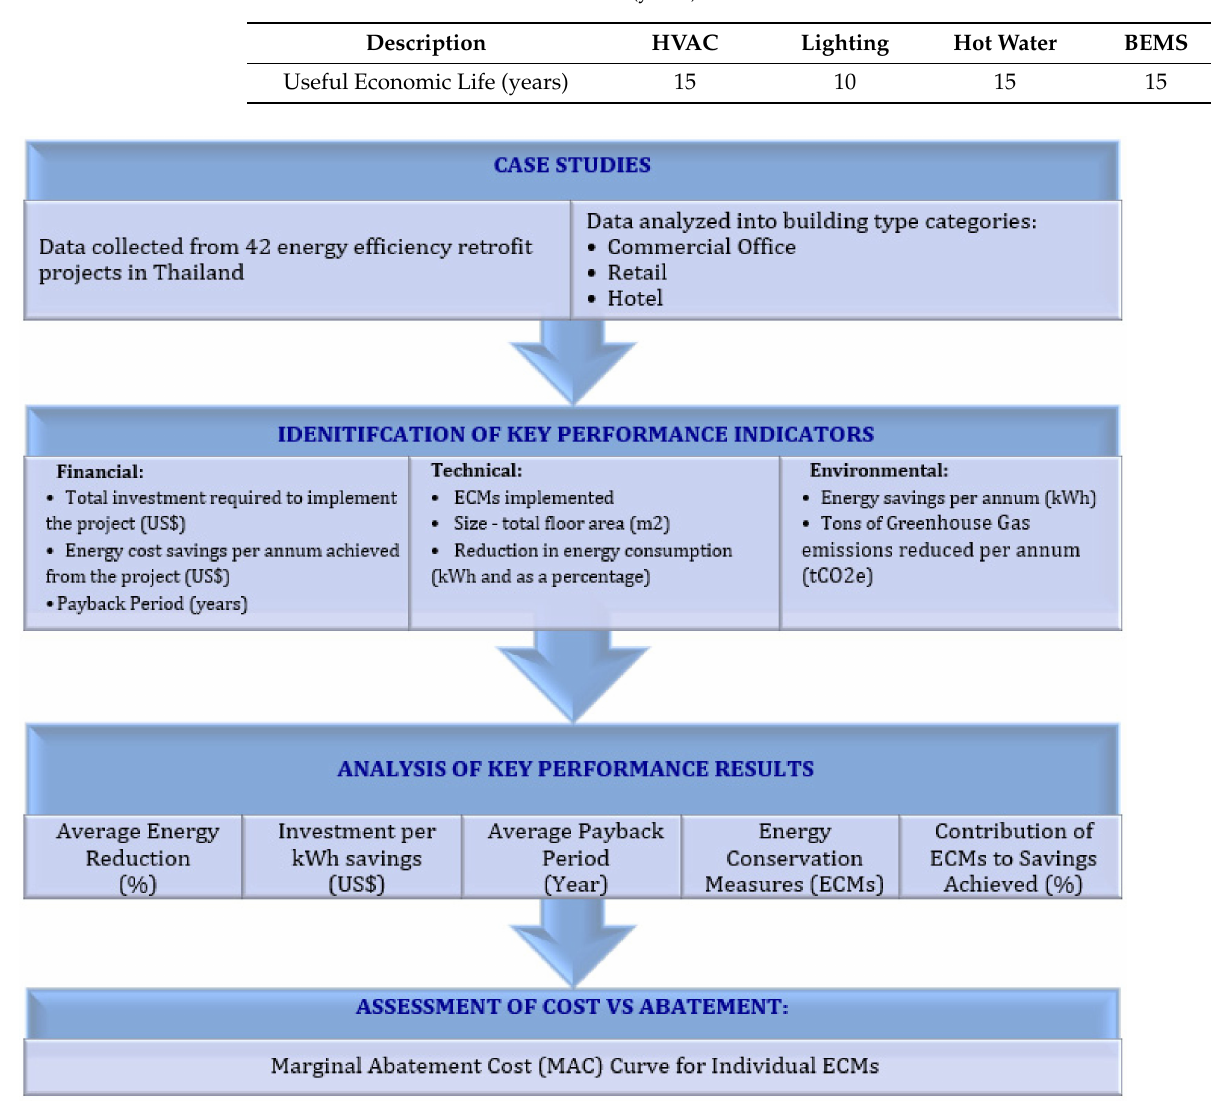
Figure 3. Summary of the overall